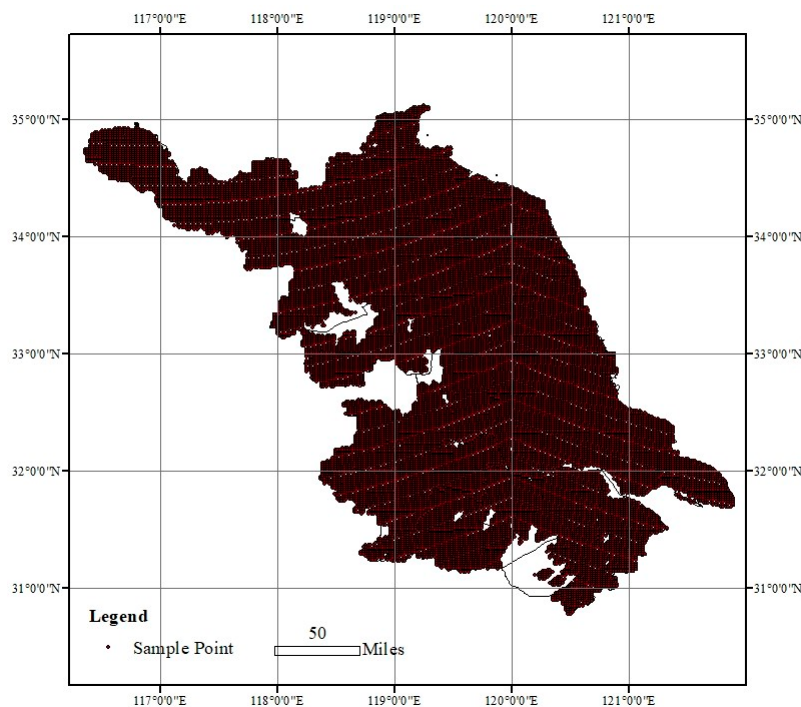
Figure 2. The distribution of soil sampling sites.